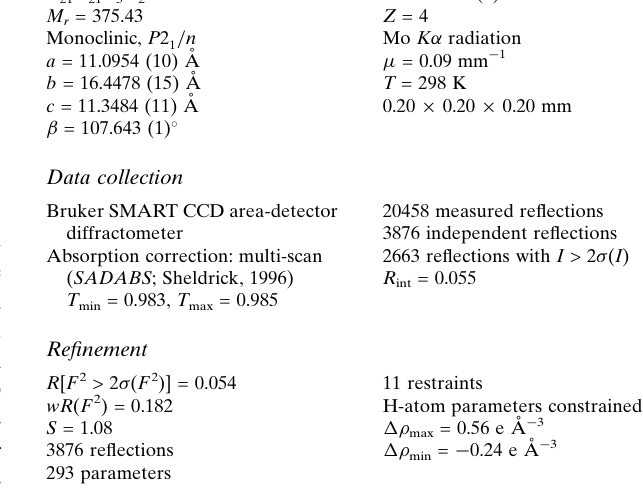
Data collection Bruker SMART CCD area-detector diffractometer Absorption correction: multi-scan ( SADABS ; Sheldrick, 1996)